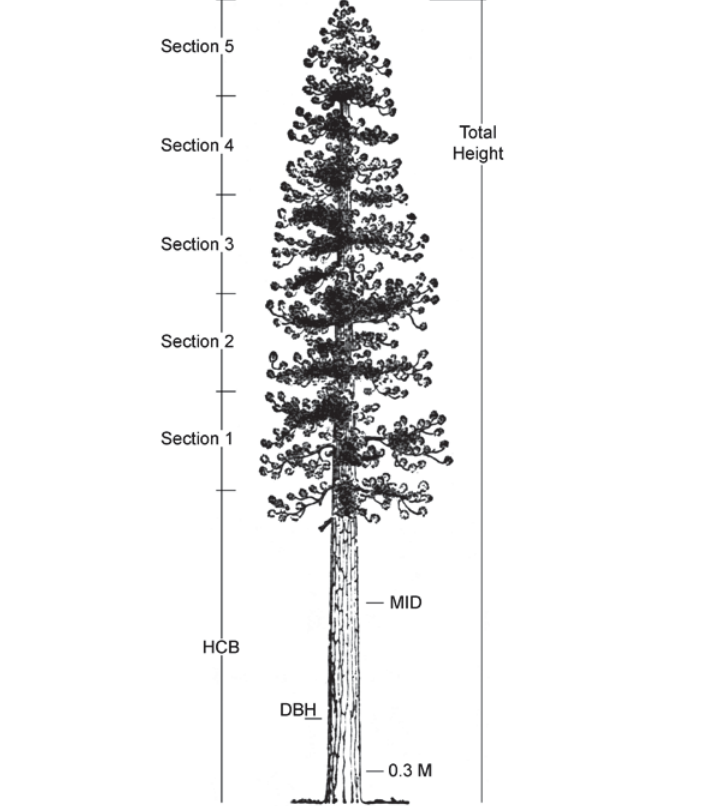
) and current basal area ( BA p , T , T ) at Blacks Mountain Experimental Forest. 2 8 10